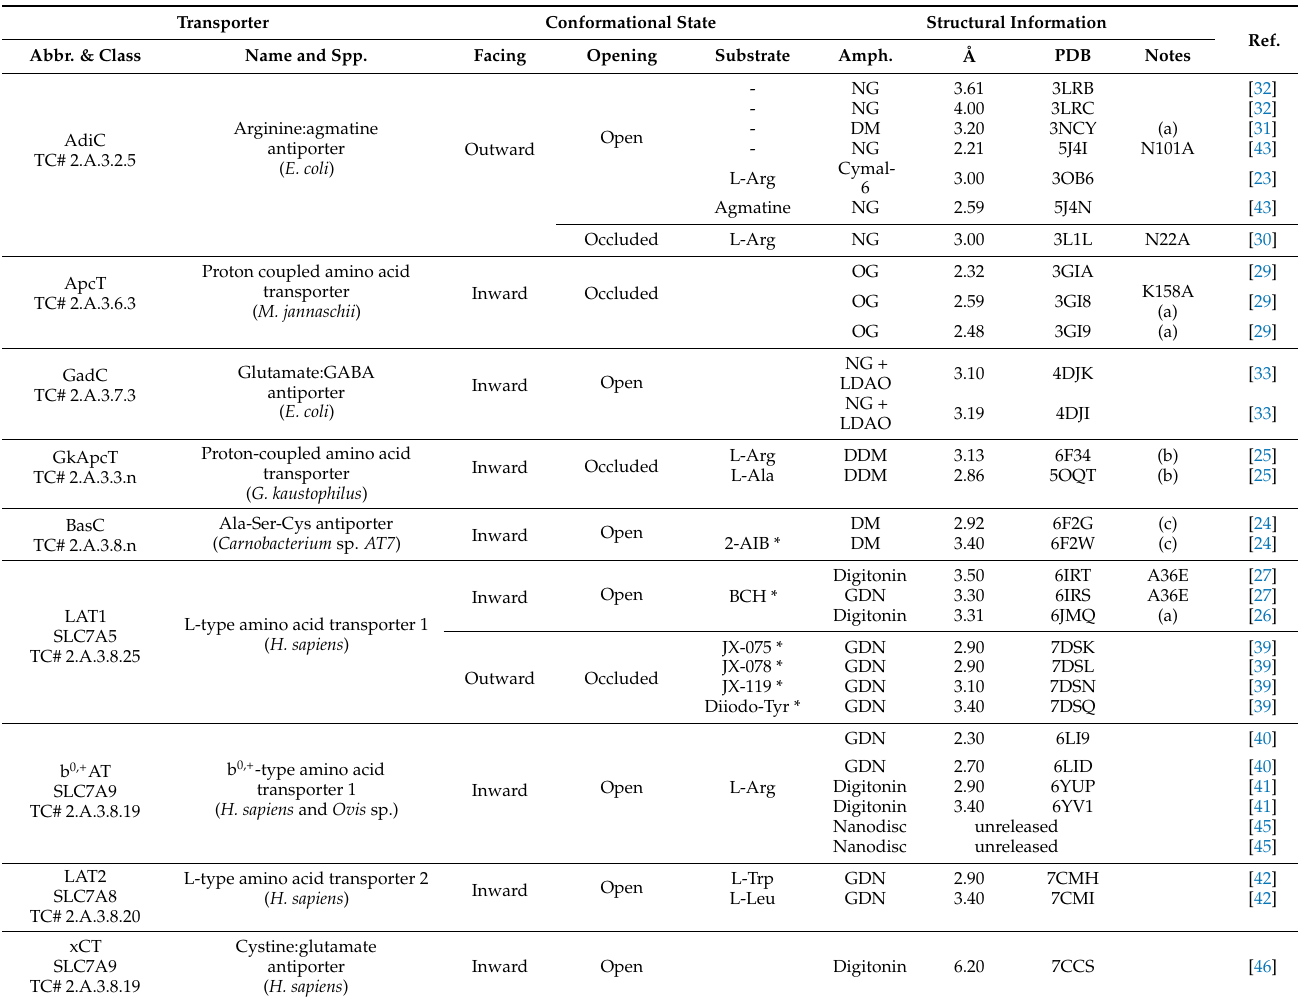
Table 1. Current APC family members with structure solved. Transporters’ abbreviated and complete names, TCDB, and/or SLC classification and corresponding species are indicated. Structures are grouped by conformational states indicating the substrate or inhibitor bound. The amphipathic compound used (Amph.) in the last step of the purification process, the overall resolution (Å), Protein Data Bank (PDB) entry codes, and notes (mutations and chaperones used) are also indicated in the structural information columns. Conformational State Structural Information